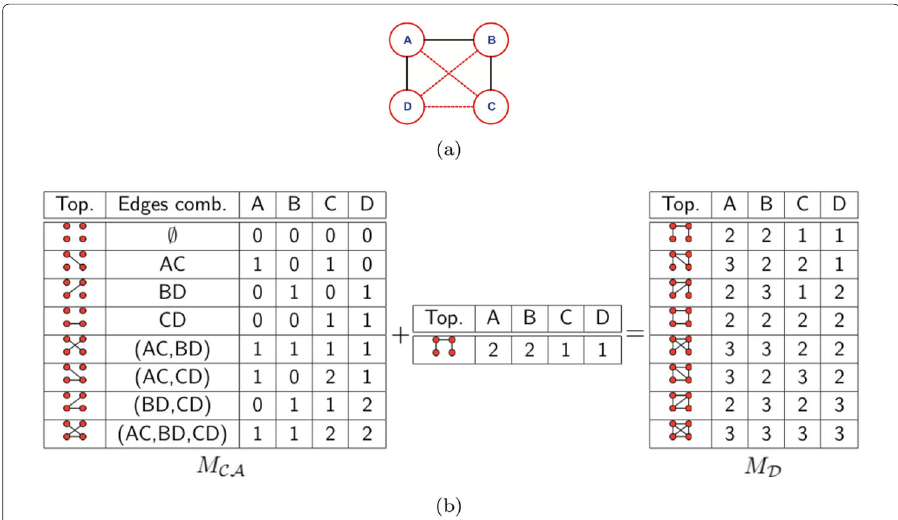
Fig. 10 a A 4-nodes path where present and absent edges are denoted with black and red lines, respectively. b From left to right: the matrix M CA of combinations of absent edges of the 4-nodes path, where M CA [ c , x ] is the number of edges in combination c to which node x is incident; node degrees of the 4-node path; the matrix M D of node degrees of motifs in the TIAS of the 4-nodes path, resulted by adding node degrees of the 4-nodes path ( 2,2,1,1 ) to each row of M